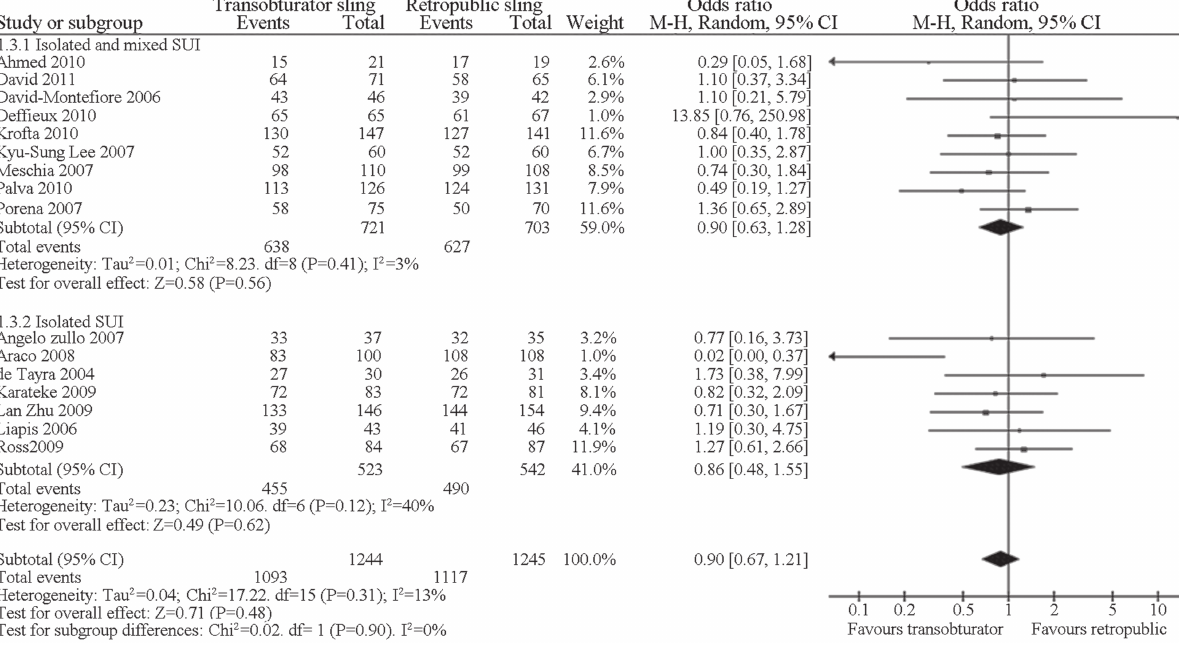
Table 1 - Sample data of the animals submitted to thermoablation using radiofrequency. Figure 1 - Meta-analysis of objective cure of SUI between transobturator and TVT approaches in the first subgroup MEDIAN SD MIN. MAX. P-VALUE